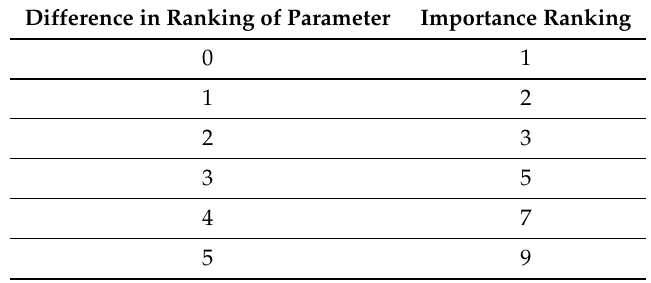
Table 12. Saaty scale based on the difference between number of vertical irregularities. Difference in Ranking of Parameter